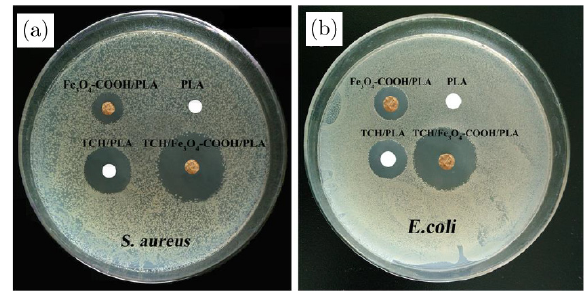
Fig. 4. Antimicrobial activities of PLA, Fe 3 O 4 -COOH/PLA, TCH/PLA and TCH/Fe 3 O 4 -COOH/PLA electrospun nano¯- ber membranes against S. aureus and E. coli .